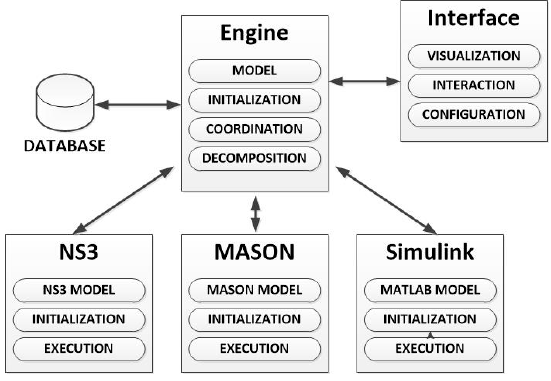
Figure 11. CPSS simulator architecture.